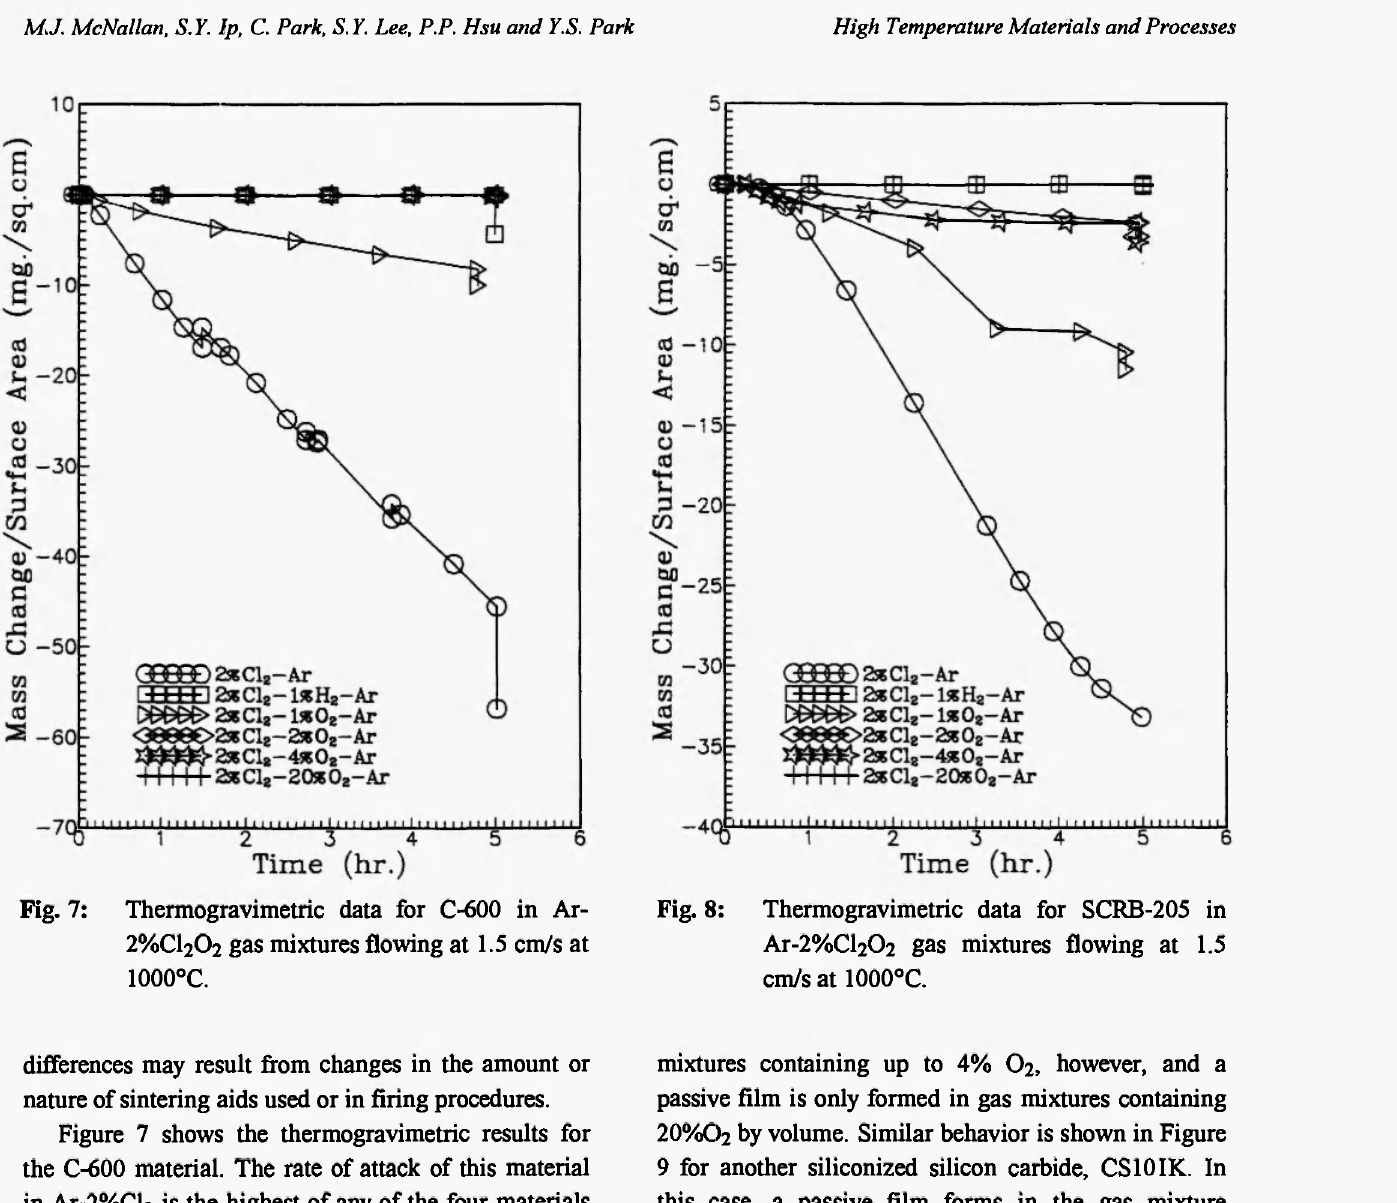
Fig. 7: Thermogravimetric data for C-600 in Ar- 2%Cl2C>2 gas mixtures flowing at 1.5 cm/s at 1000°C.